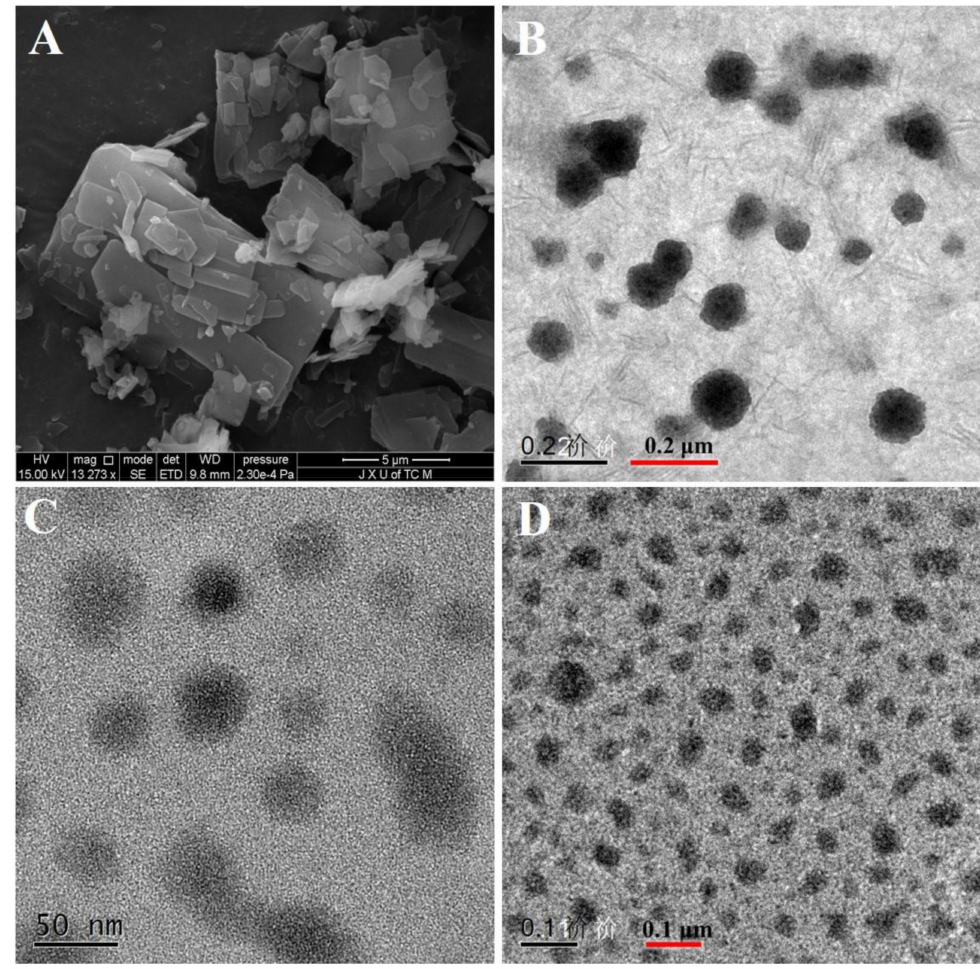
Figure 3. The SEM photo of DOC ( A ); the TEM photos of DOC(Nc) ( B ), DOC@mPEG-PLA ( C ), and DOC(Nc)@mPEG-PLA ( D